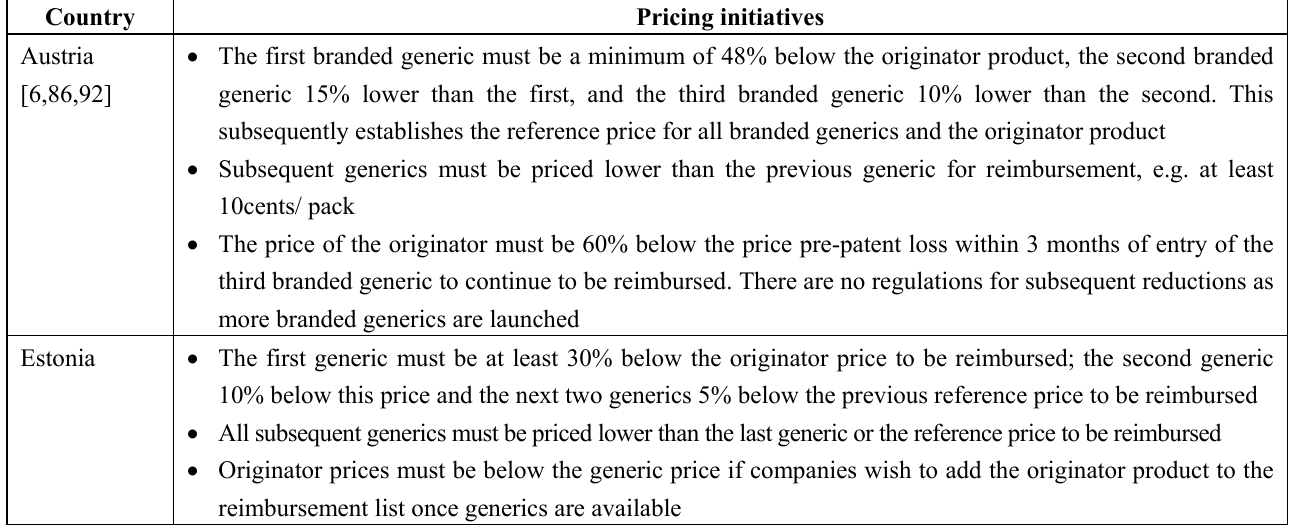
Table A4. Mixed approaches to the pricing of generics in exemplar European countries.